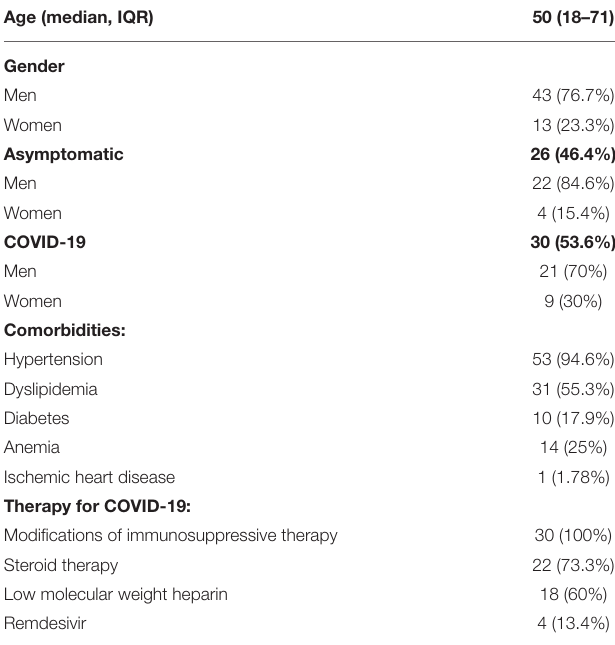
TABLE 1 | Anagraphical and clinical features of patients with kidney transplant with SARS-CoV-2